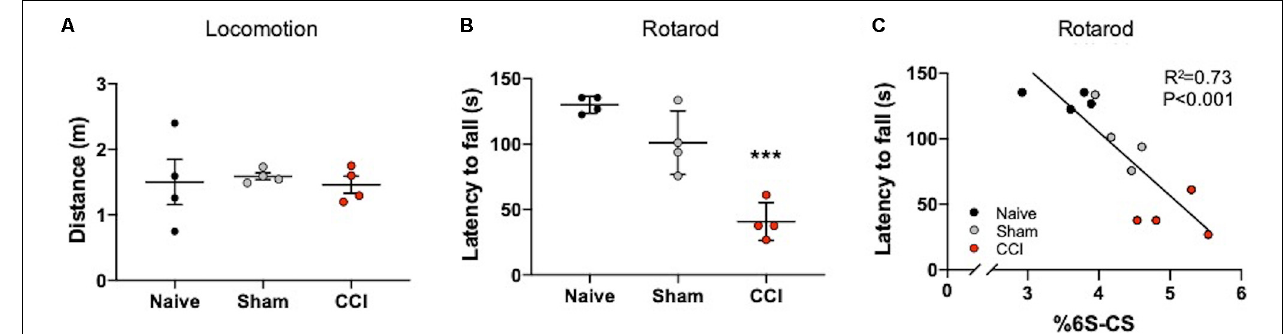
FIGURE 4 | Motor coordination deficits correlate with the abundance of thalamic 6S-CS after cortical brain injury. No differences in locomotion were measured in mice subject to the Open Field Task at 7 days post-CCI, or sham procedure, compared to naïve control mice (A) . Rotarod testing revealed significant motor coordination deficits in CCI mice as evidenced by a reduced latency to fall from the apparatus (B) . The relative abundance of 6S-CS in the ipsilateral thalamus was significantly correlated to latency (C) . (A,B) One-way ANOVA Dunnett’s post hoc test. (C) Linear regression. Values represent means ± SD ( n = 4, *** P < 0.001